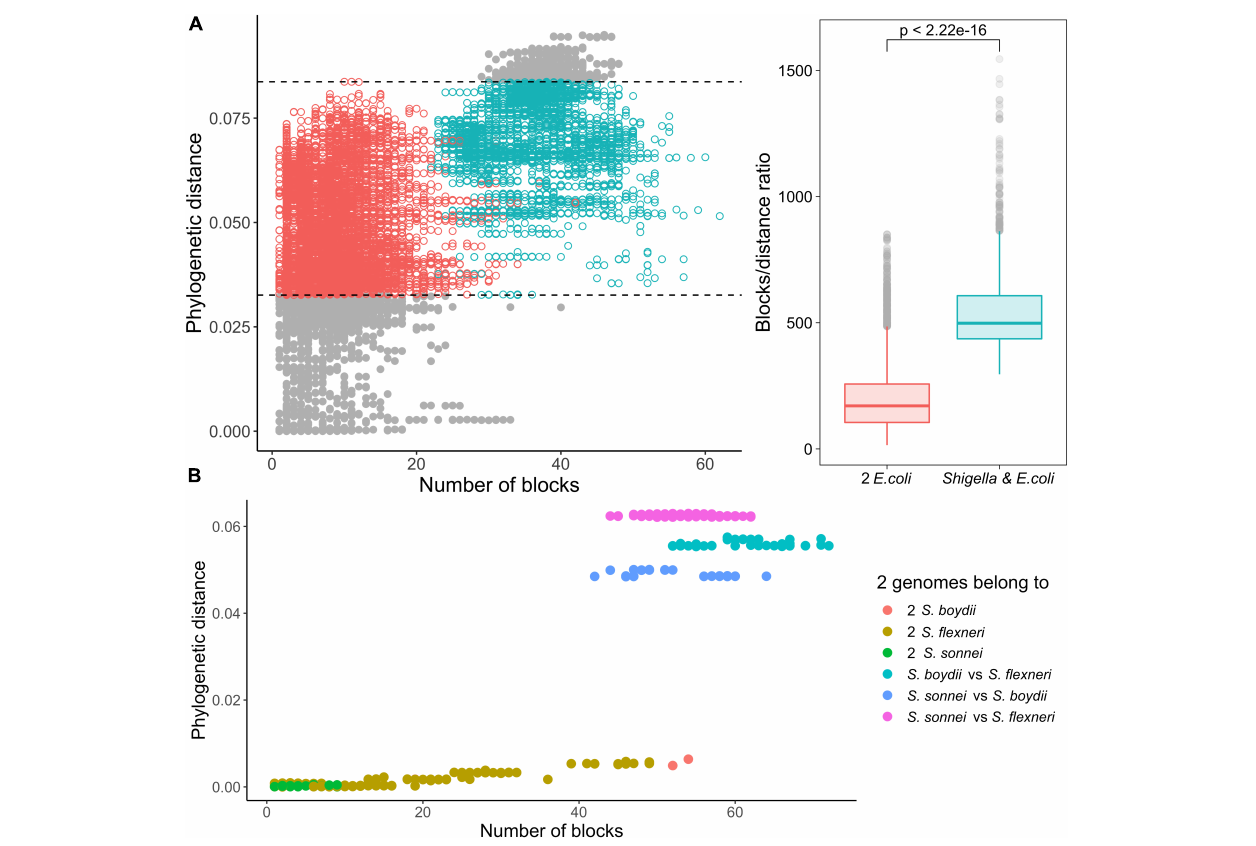
FIGURE 6 | Comparison of the ratio of phylogenetic distance to the number of synteny blocks for genome pairs from phylogroup B1. (A) Each pair consists of one Shigella spp. and one E. coli genome (the red dots) or two E. coli genomes (the green dots). Only genome pairs in the intersection were compared. The Wilcoxon–Mann–Whitney test p -value is given. (B) Each pair consists of two Shigella